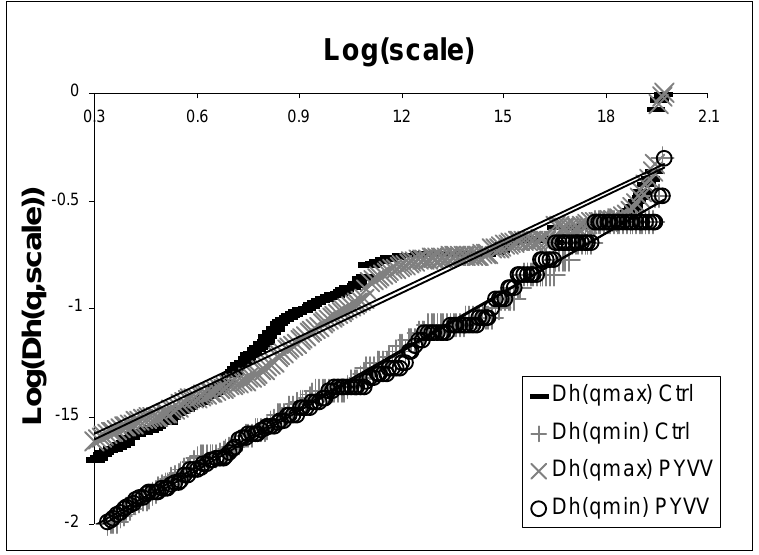
Figure 3. Scale invariance assessment for the reflectance data of healthy and infected plants. Dh(q, scale) is the numerator of Equation 6 in the Appendix for each order moment q > 0 along the wavelength scale. The slopes correspond to the Hölder